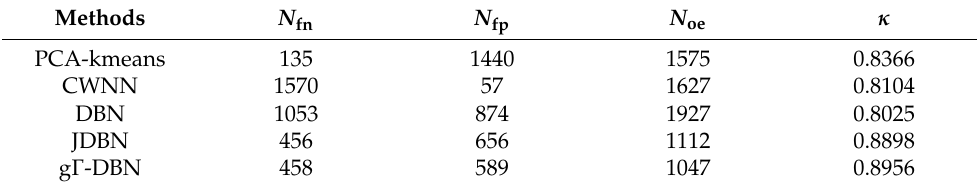
Table 3. Quantitative evaluation of the Farmland data Table 2. Quantitative evaluation of image patch size 𝜔 in three data sets.